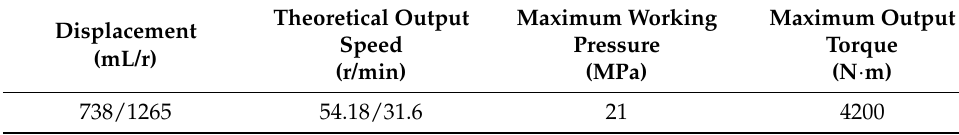
Table 2. Main parameters of hydraulic walking motor.